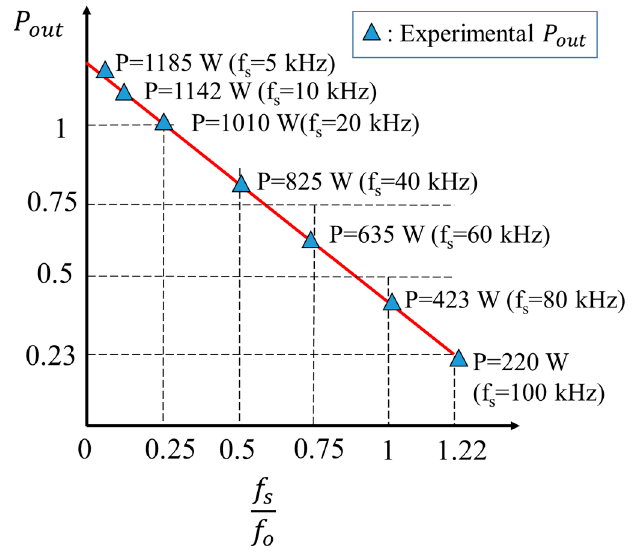
Figure 13. Characteristics of output power (cid:1842) (cid:3042)(cid:3048)(cid:3047) versus switching frequency ratio (cid:1858) (cid:3046) /(cid:1858) (cid:3042) .